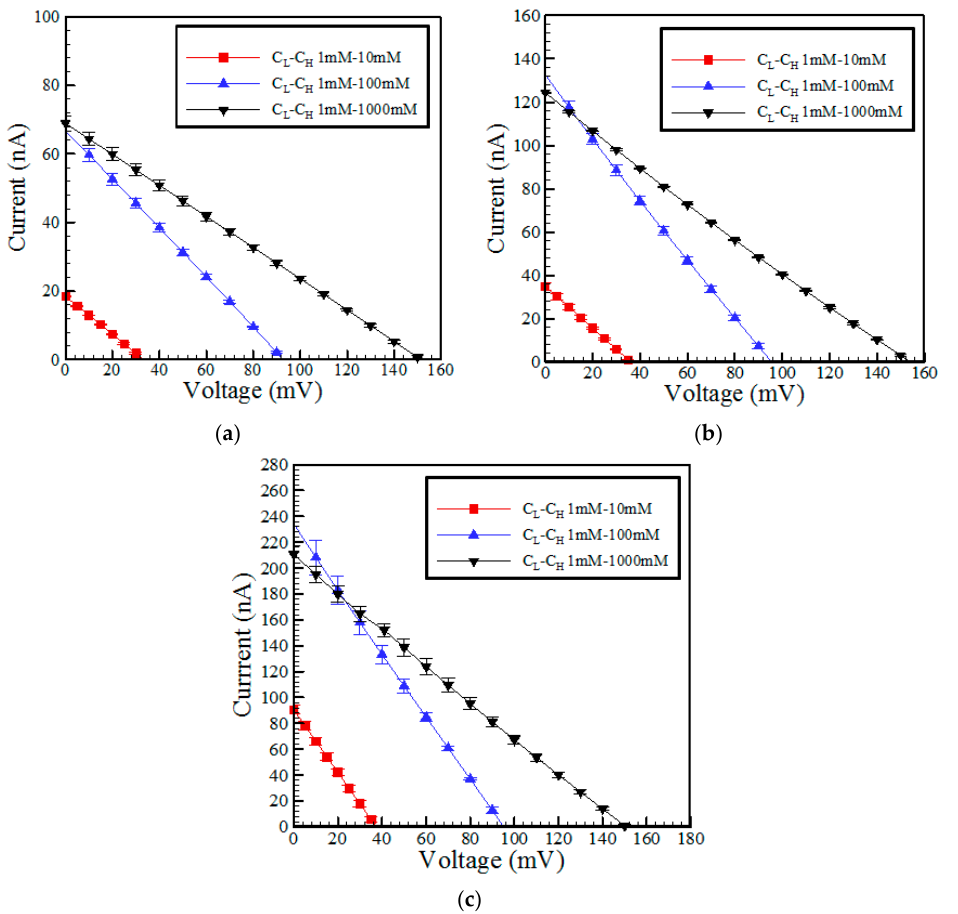
Figure 9. Current-potential curves for the different concentration ratios in RED devices with microchannels of lengths of: ( a ) 3 mm; ( b ) 2 mm; and ( c ) 1 mm.